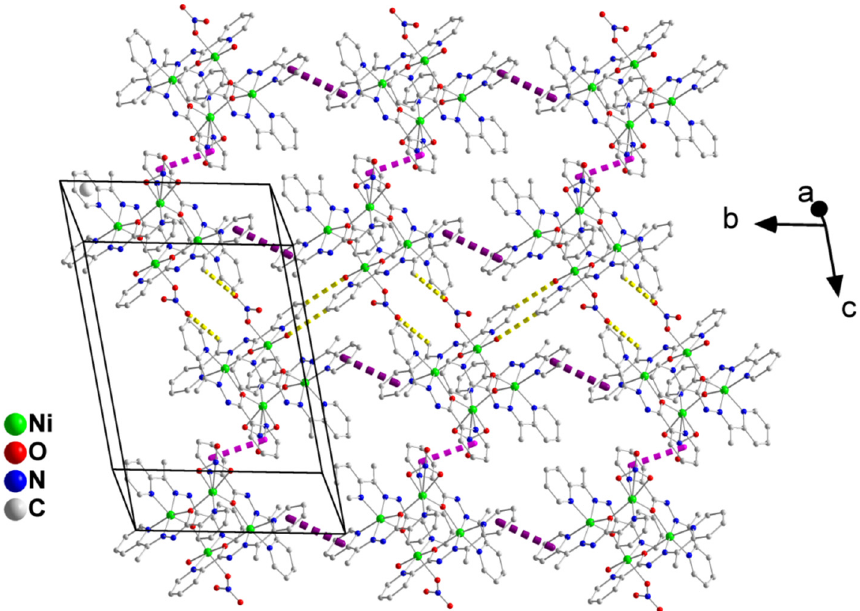
Figure 4. A layer of the tetranuclear cations of complex 2· 0.2H 2 O·3EtOH parallel to the (100) plane. The dashed pink and violet lines indicate interchain and intrachain, respectively, π – π stacking interactions. The dashed yellow lines represent interstripe H-bonding interactions.